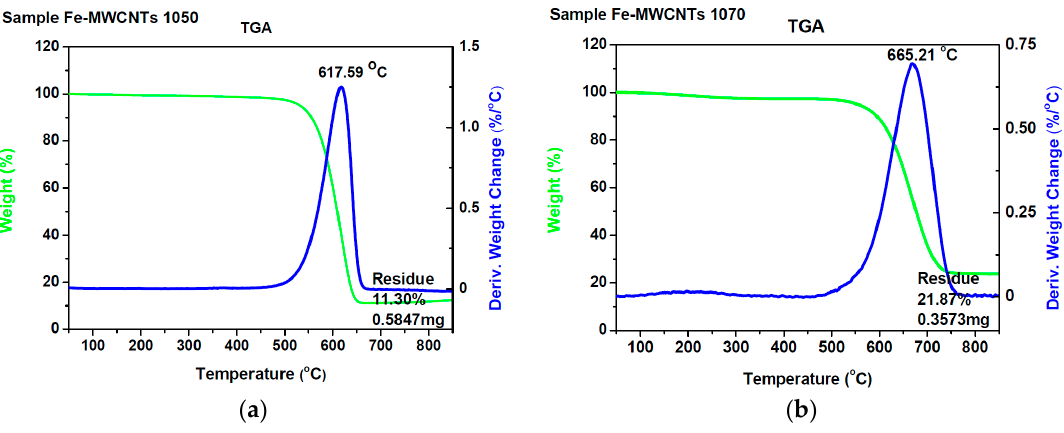
Figure 11. Thermogravimetry (TGA) thermographs of samples synthesized at ( a ) 1050 K; ( b ) 1070 K.